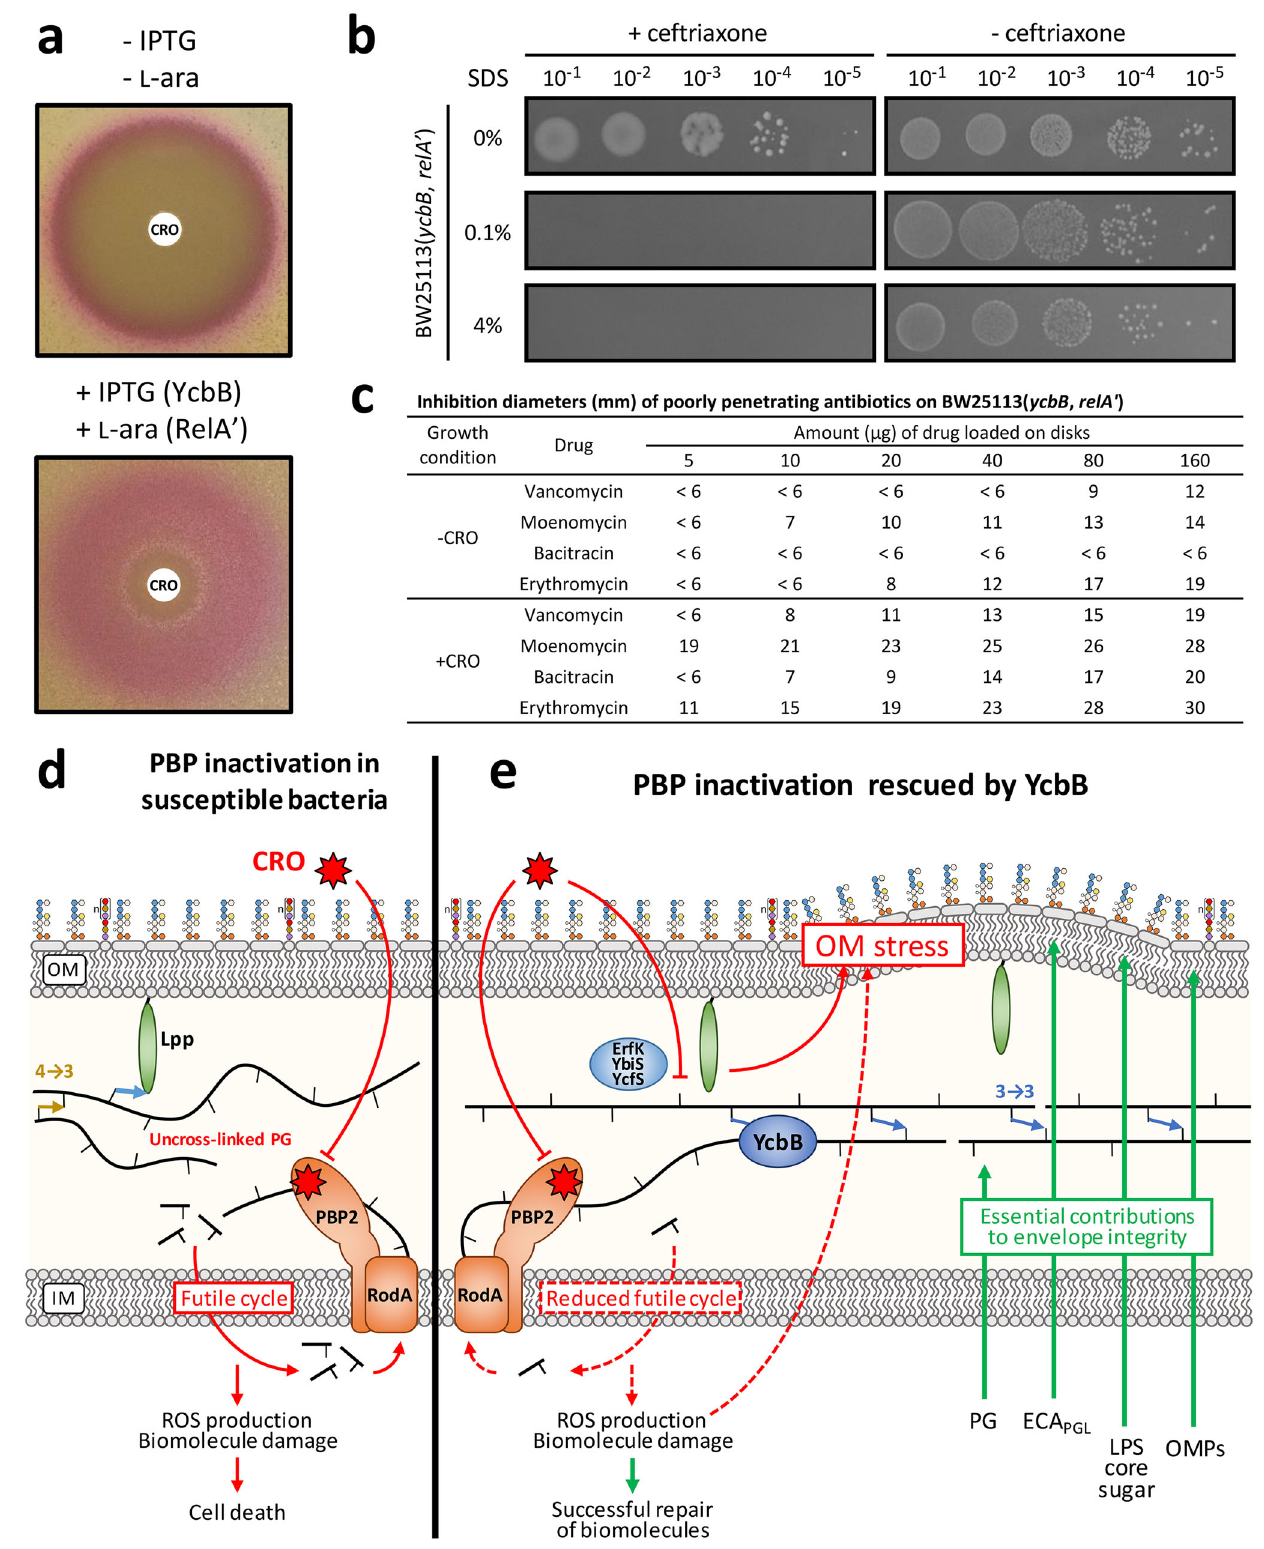
Fig. 6 | Testing outer membrane permeability in the presence of ceftriaxone. a Hydrolysis of chromogenic CPRG at 20 µ g/ml by cytoplasmic LacZ 63 . The disks were loaded with 30 µ g ceftriaxone. b Plating ef fi ciency in the presence of SDS. Growth was tested in the presence of ceftriaxone at 8 µ g/ml (+ceftriaxone) or in the absence of the drug ( − ceftriaxone) on BHI agar plates supplemented with 40 µ M IPTG and 1% L -arabinose for induction of ycbB and relA ’ , respectively. c Inhibitiondiametersofdrugsthatdonotpenetratetheoutermembraneofwild-